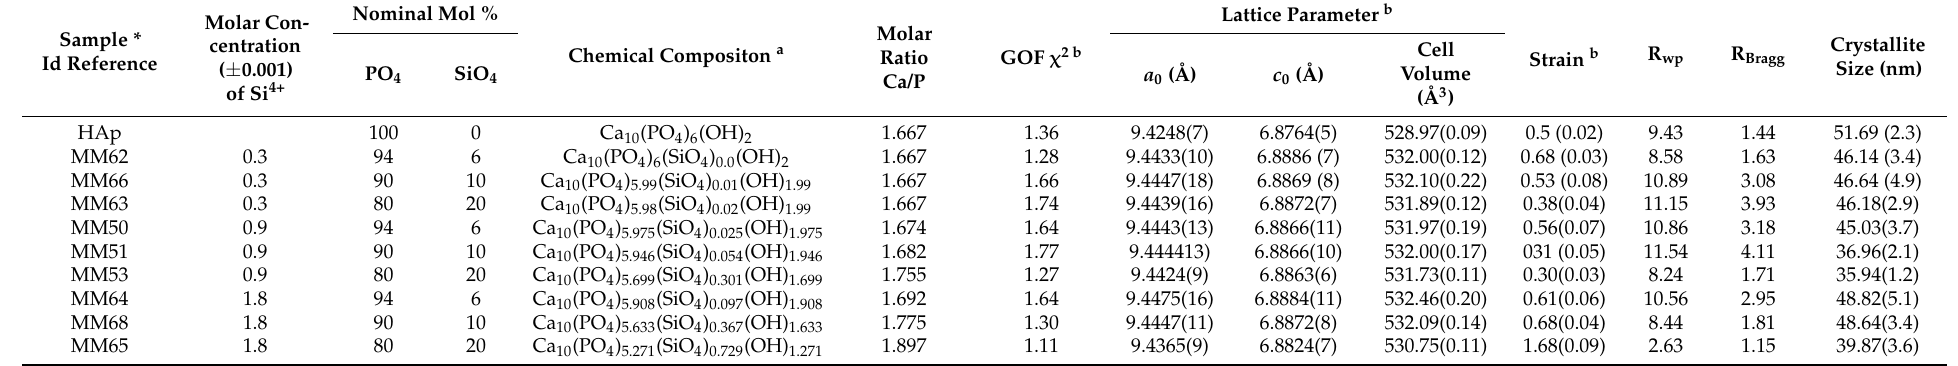
Table 1. Chemical and physical features of Si-HAp powders prepared under hydrothermal-assisted microwave treatments at 150 ◦ C for 1 h using different concentrations of TMAS solutions and tripolyphosphate as a P